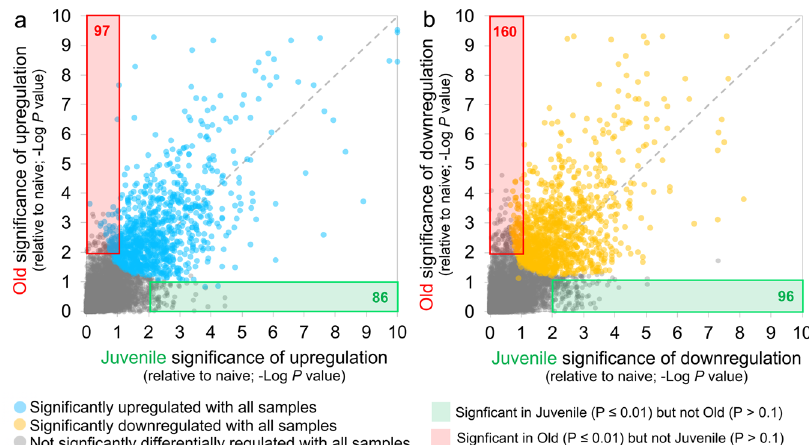
Fig. 3 86 genes were signi fi cantly upregulated and 96 genes were signi fi cantly downregulated with COVID-19 only in juvenile macaques. Heatmaps visualizing the signi fi cance values of COVID-19 a upregulated and b downregulated genes, in juvenile and old macaques. Green shaded areas contain genes signi fi cant only in juveniles, and red shaded areas contain genes signi fi cant only in old macaques.